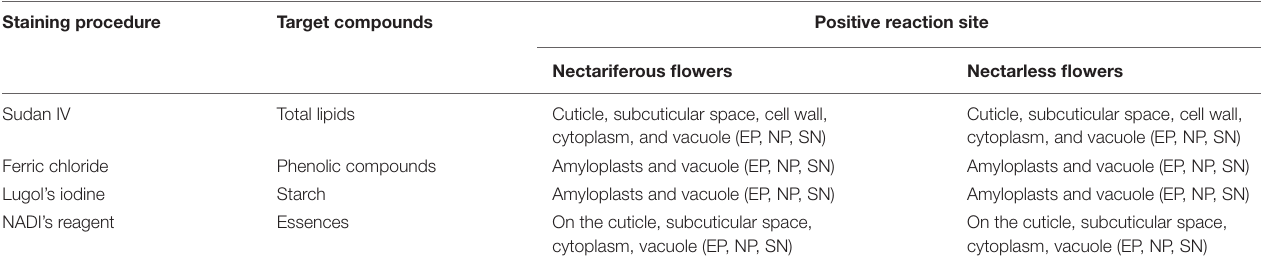
TABLE 1 | Histochemical tests on the secretory disk in nectariferous and nectarless flowers of Jacaranda oxyphylla (Bignoniaceae). Staining